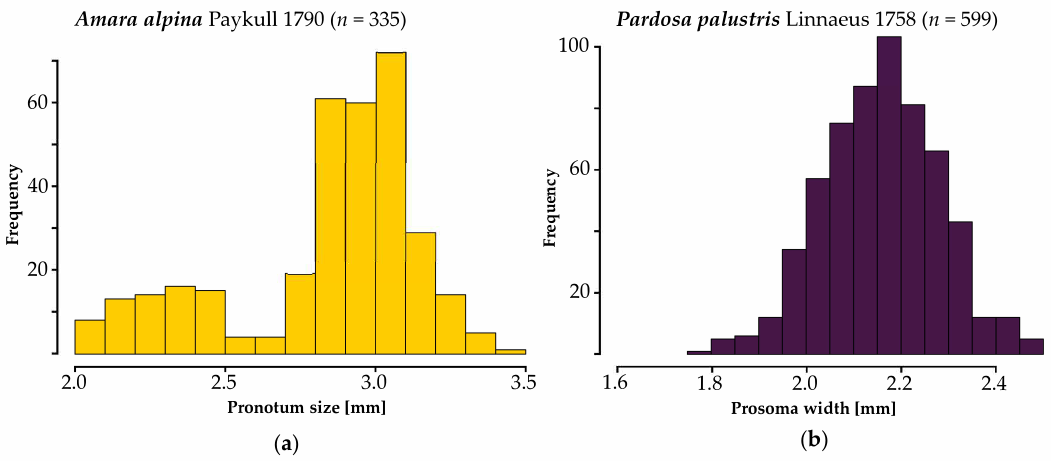
Figure 1. Frequency histograms of pronotum width ( Amara alpina , ( a ); n = 335) and prosoma width ( Pardosa palustris , ( b ); n = 599) in this study. The color scheme ( A. alpine —yellow, P. palustris —dark blue) is used in subsequent figures to enhance